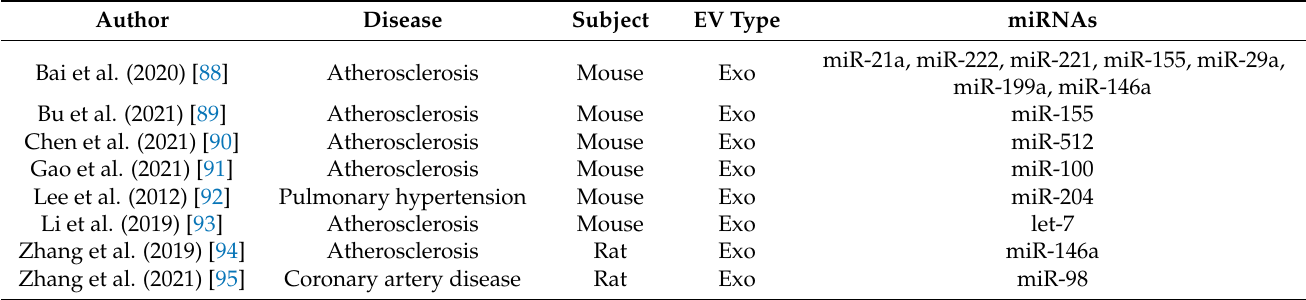
Table 5. Extracellular miRNAs in vesicular disease.